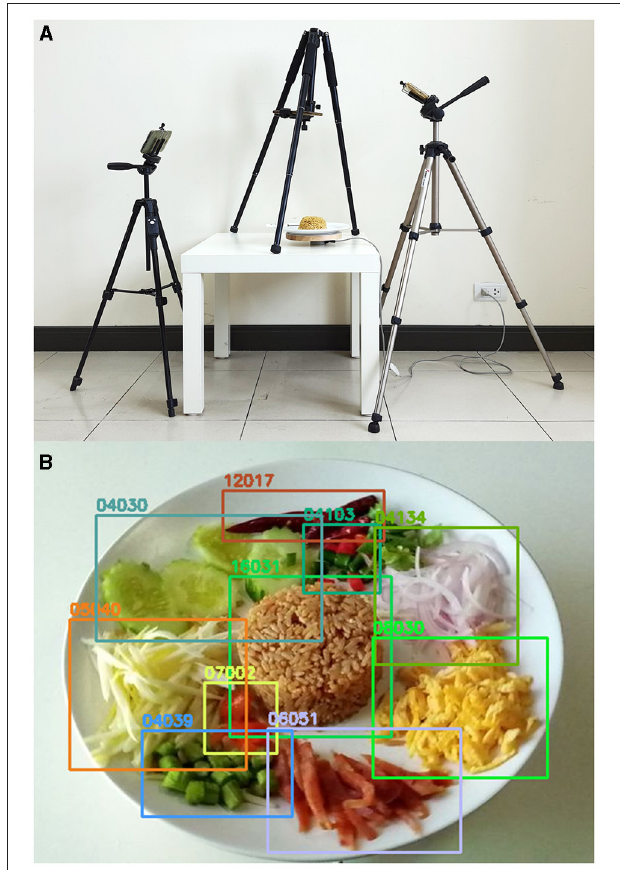
FIGURE 3 | (A) Image acquisition setup for building the image dataset and (B) demonstration of how a dietitian annotated the ingredients of Khao-kluk-kapi (fried rice with shrimp paste), including fried rice with shrimp paste (16031), thin sheets of fried egg (08030), Kun-chieng (dried sweet pork sausage) (06051), yardlong bean (04039), unripe mango (05038), cucumber (04030), dried chili (12017), bird’s eye chili (04103), and dried shrimp (07002). The five-digit code is the INMUCal food